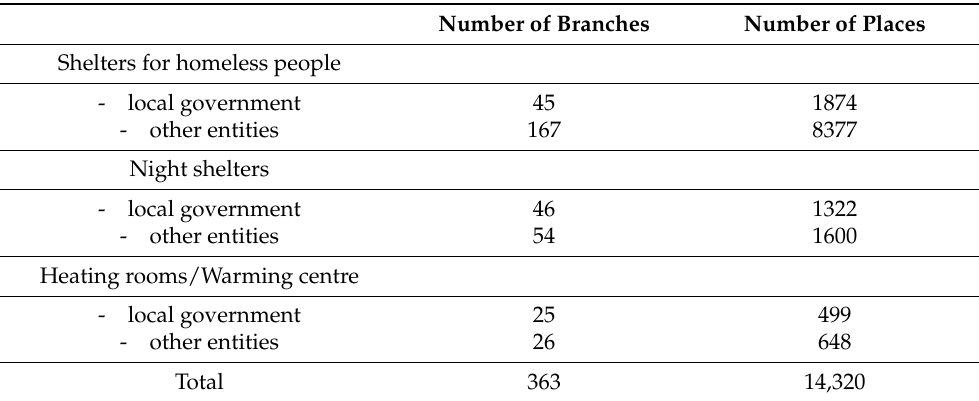
Table 1. Number of accommodation facilities for homeless people in 2016, broken down into entities that run them in